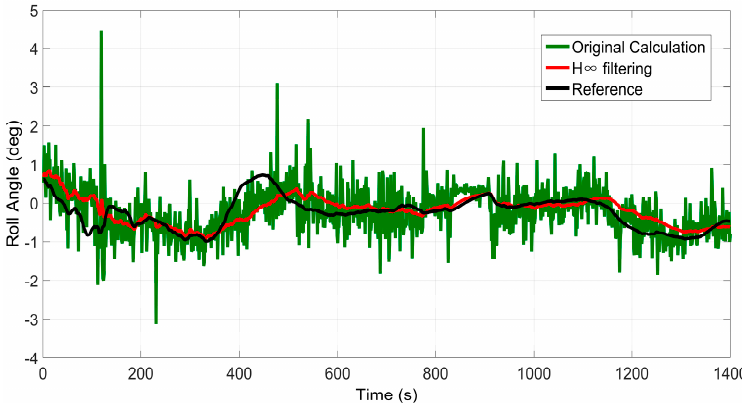
Figure 6. Results of roll angle estimation in trajectory 1.